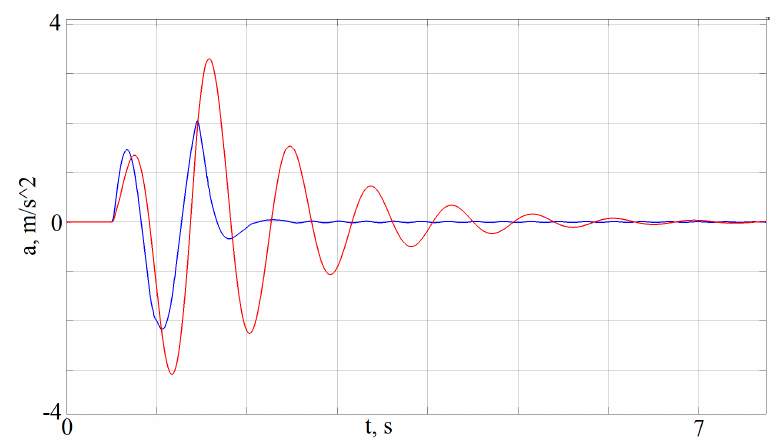
Figure 17. Desired force on the rod generated by the high level PID controller (red) and actual force on the rod (blue).